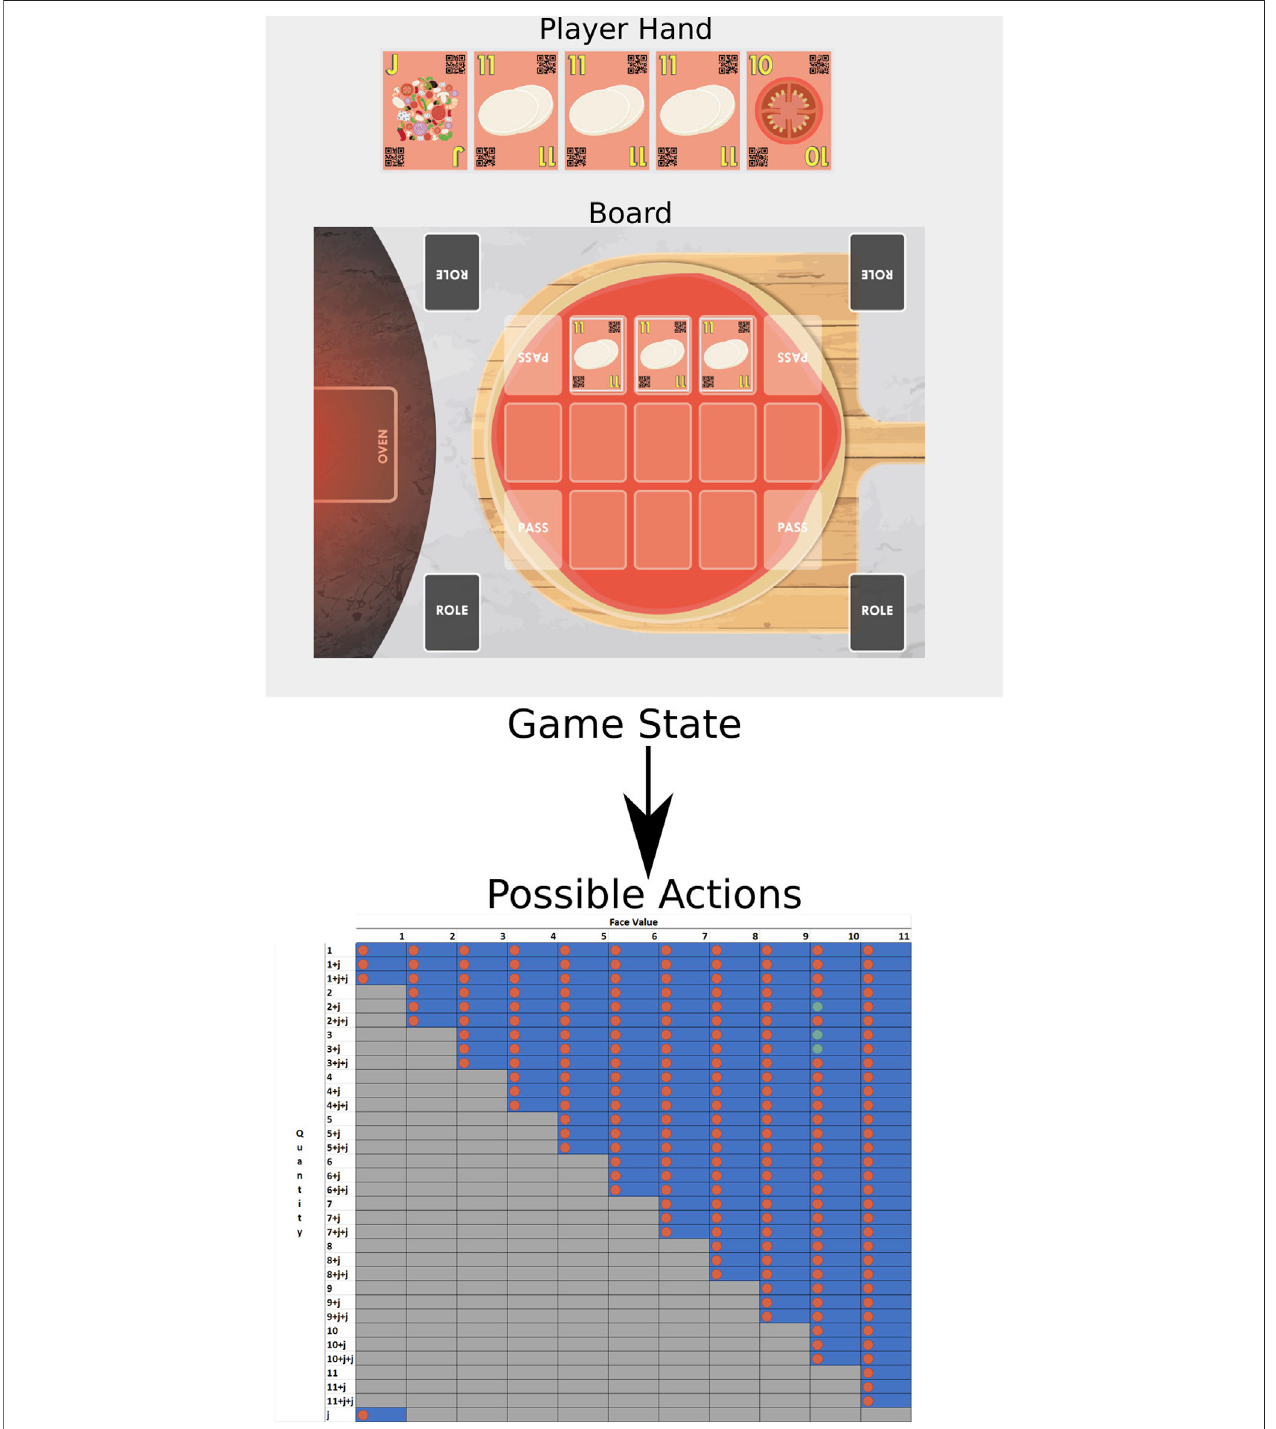
FIGURE4| Exampleofpossibleactionsgivenacertaingamestate.Thecolumnsrepresentthecardfacevalues,andtherowsrepresentthenumberofcardstobe discarded. The letter “ j ” represents the presence of a joker. The lookup table is created on the fl y, and it marks all the actions which are allowed based on the game mechanics (blue regions) and the ones which are not allowed (gray regions). For this given game state, the player would be allowed to only perform the actions marked with the green dots.